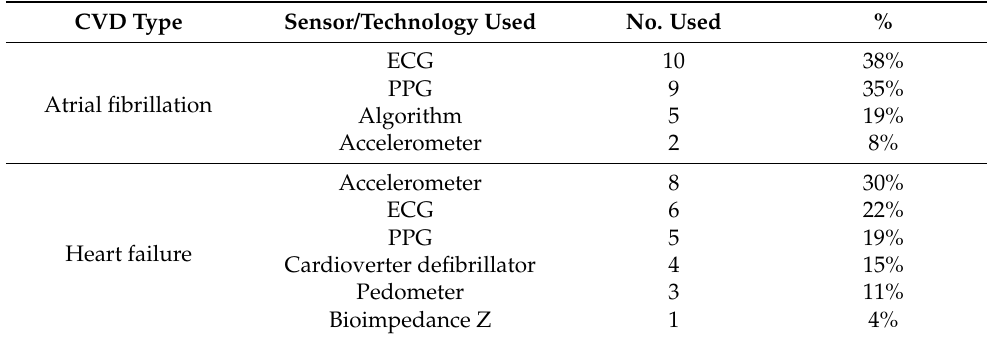
Table 5. Sensors and technology implemented in noncommercial wearables for CVD